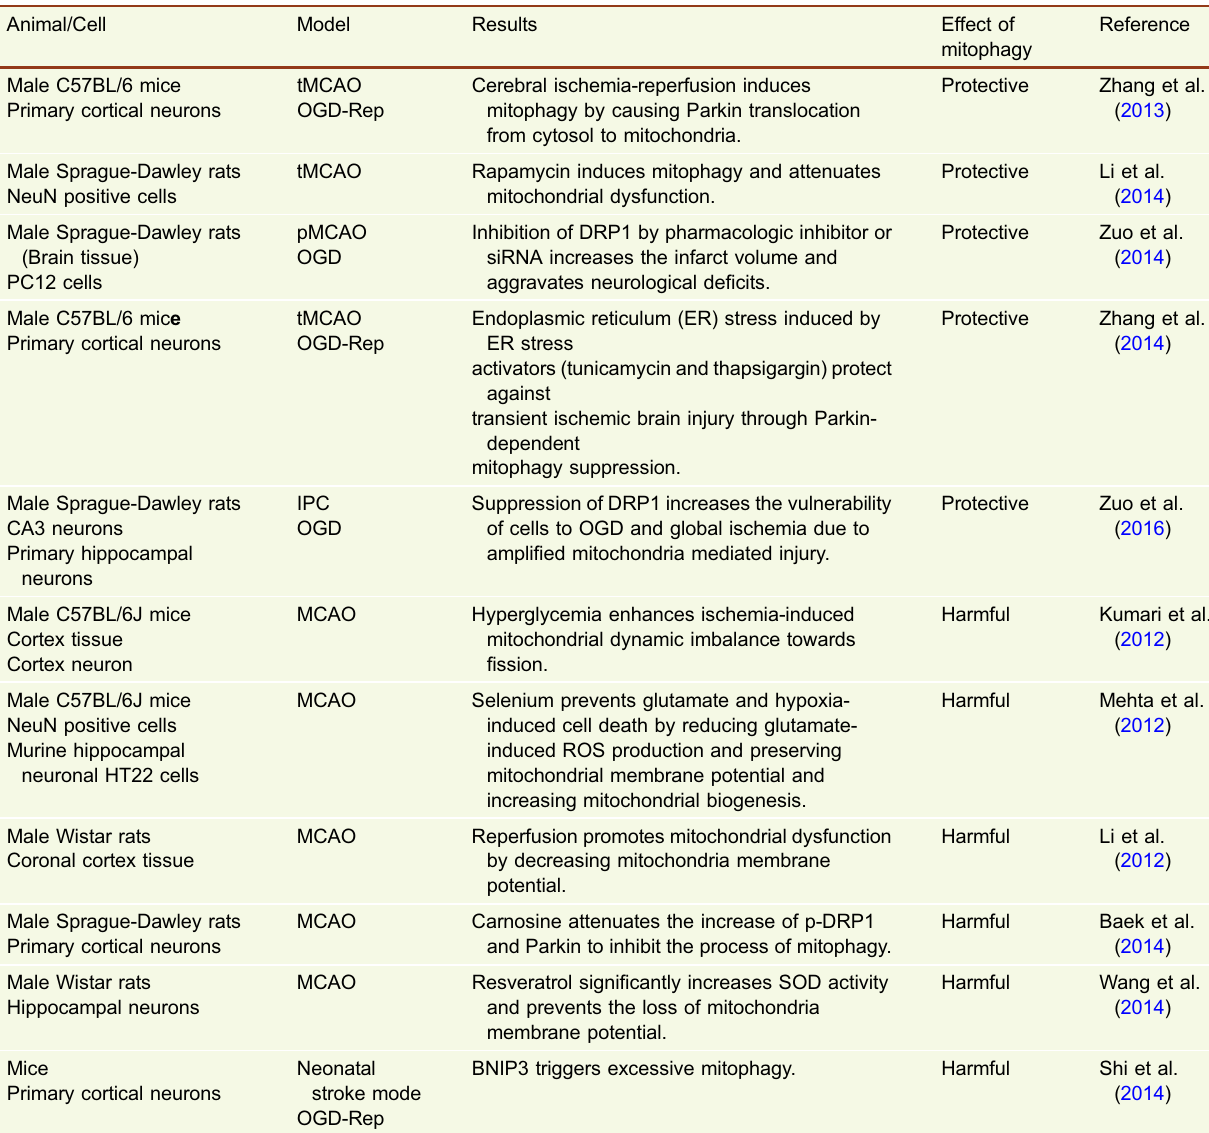
Table 1. Highlights of research fi ndings on the roles of mitophagy in cerebral ischemia